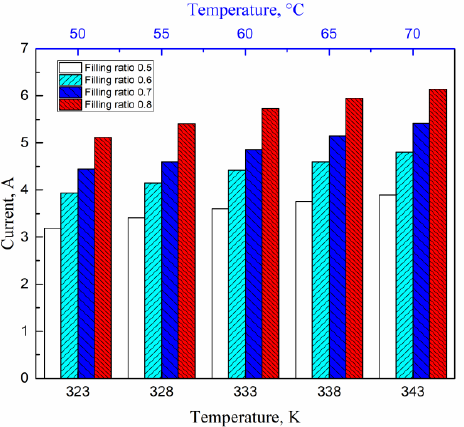
Figure 12. Relationship between the current and filling rate in the physical simulation.